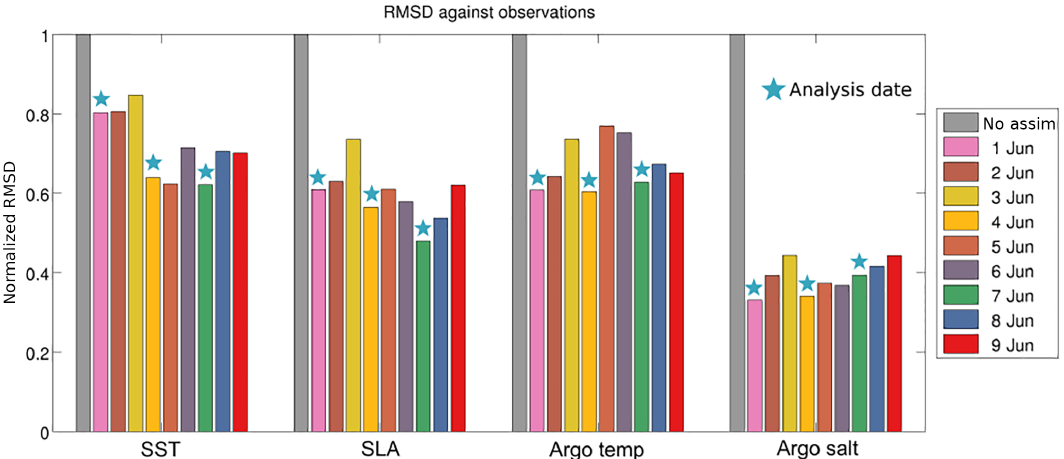
Figure 8. Evolution of the normalized RMSD against observations for the spin-up simulation.